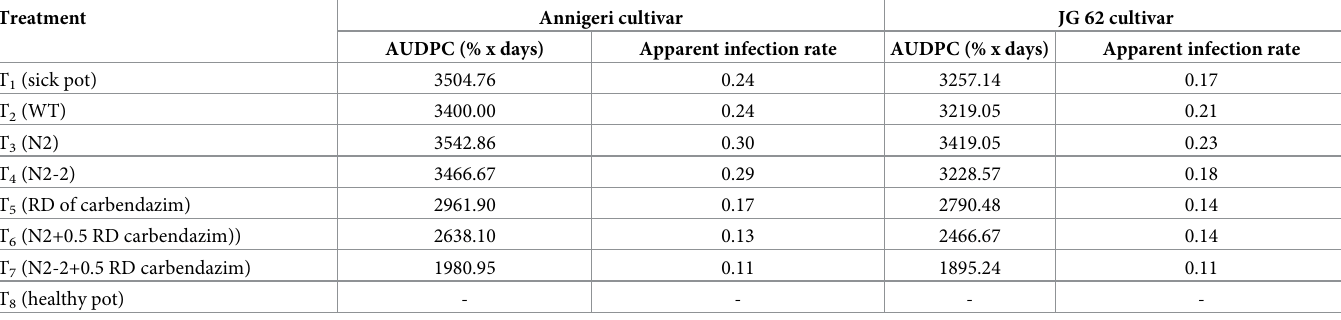
Table 3. Area under disease progress curve (AUDPC) and estimated apparent infection rate ( r ) in different treatments for chickpea dry root rot management under glasshouse conditions.